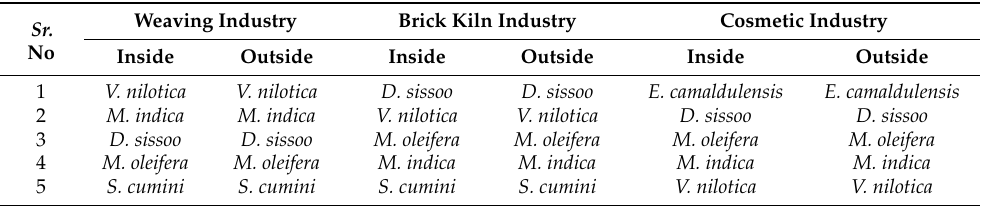
Table 1. Different trees species present in different industries.